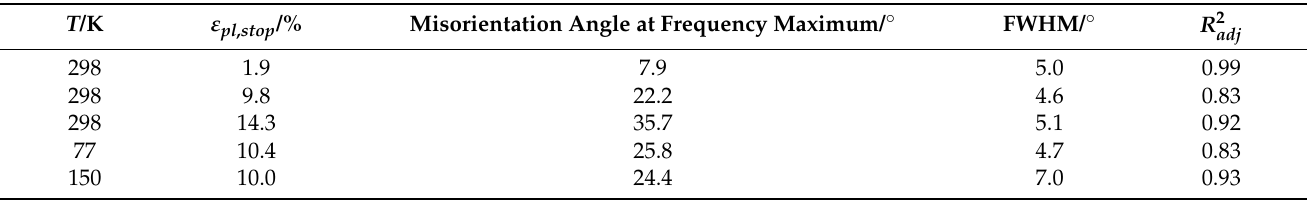
Table 4. Characteristic values of kink band misorientation angles determined by Bi-Gaussian fit function to characterize kink band properties at varying deformation conditions. FWHM: full width at half maximum. T